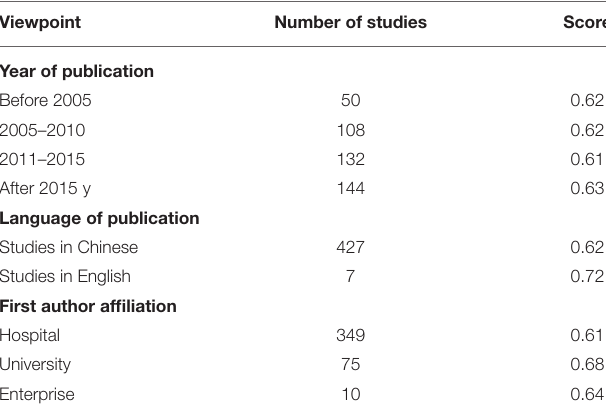
TABLE 5 | Scoring comparison from different viewpoints for included pharmacoeconomic studies ( N = 431).